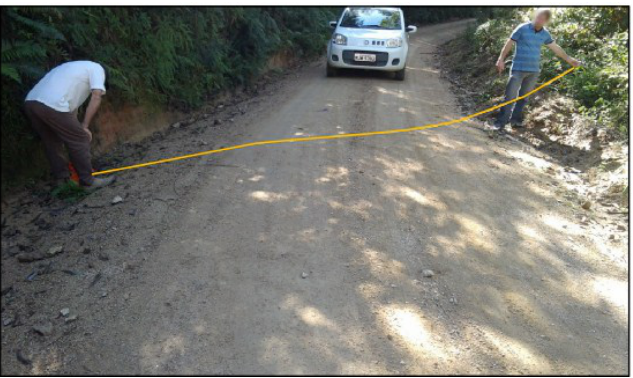
Figure 4. Checking the required length for a culvert.